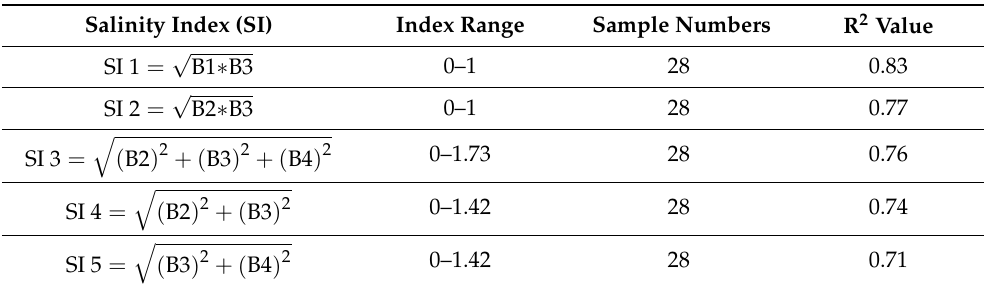
Table 6. Results of linear regression analysis for five different salinity indices used in the Tuz Lake Region, Turkey [42].